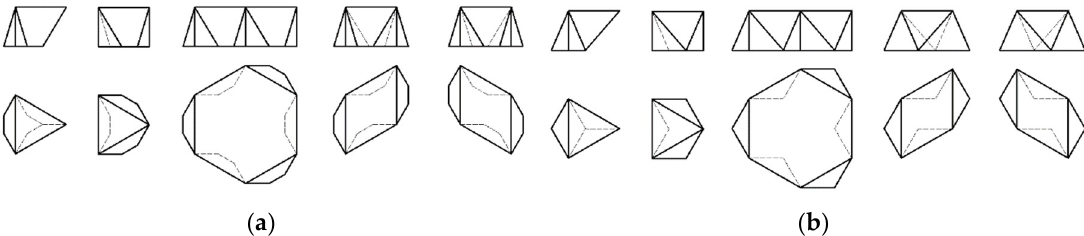
Figure 13. Dimensional restrictions in triangular components inspired by Frezier blocks. Figure 14. Double-sided smooth vault components based on an equilateral triangle, a regular hexagon, and a rhombus, inspired by Frezier blocks: ( a ) of the first type; and ( b ) of the second type.